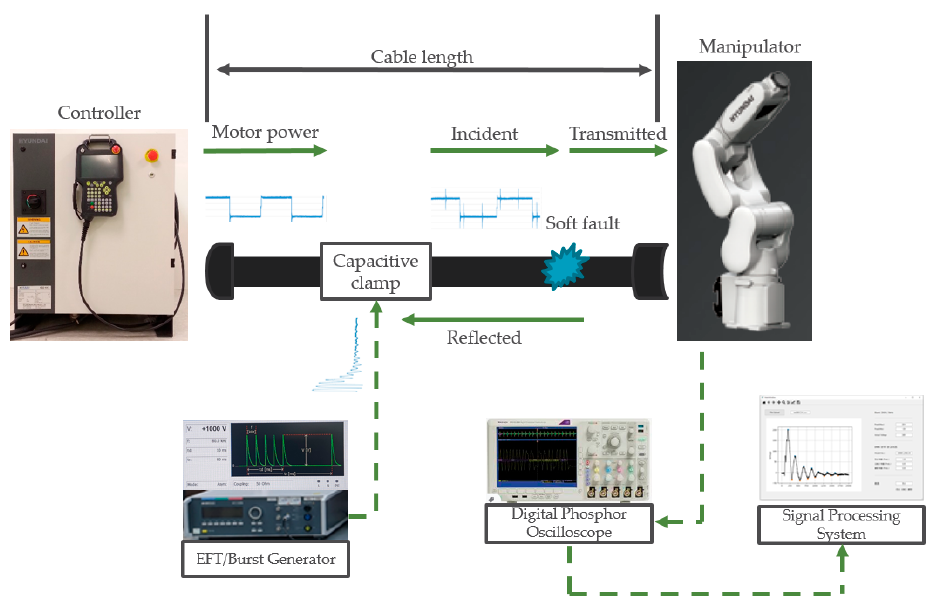
Figure 13. Schematic diagram of the fault diagnosis system.